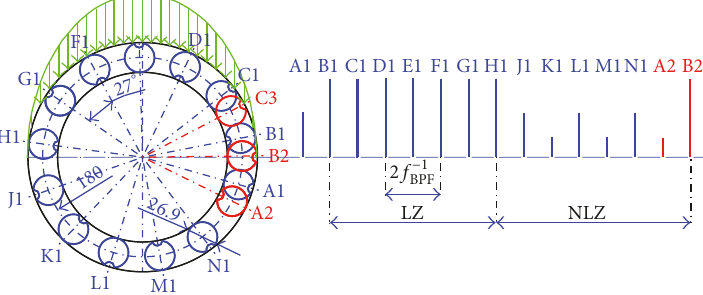
Figure 17: Interaction relations between the roller defect and inner-outer races.